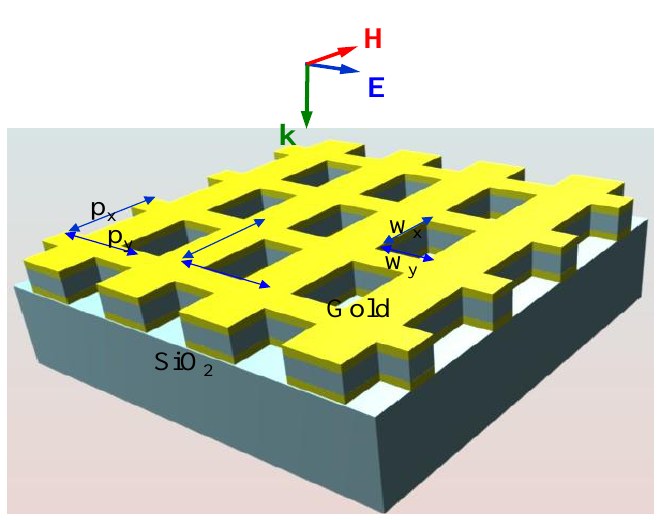
Figure 1. A schematic of a fishnet